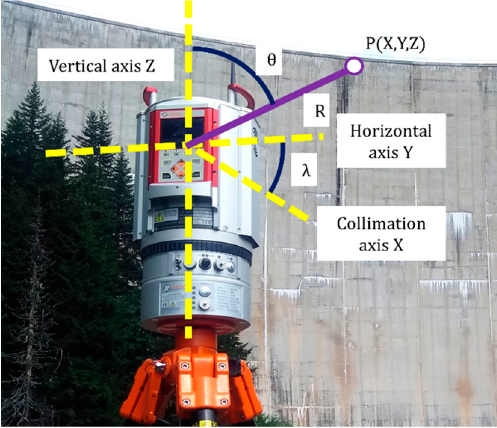
Figure 1. Example of Riegl Terrestrial Laser Scanner (TLS) and main axes.